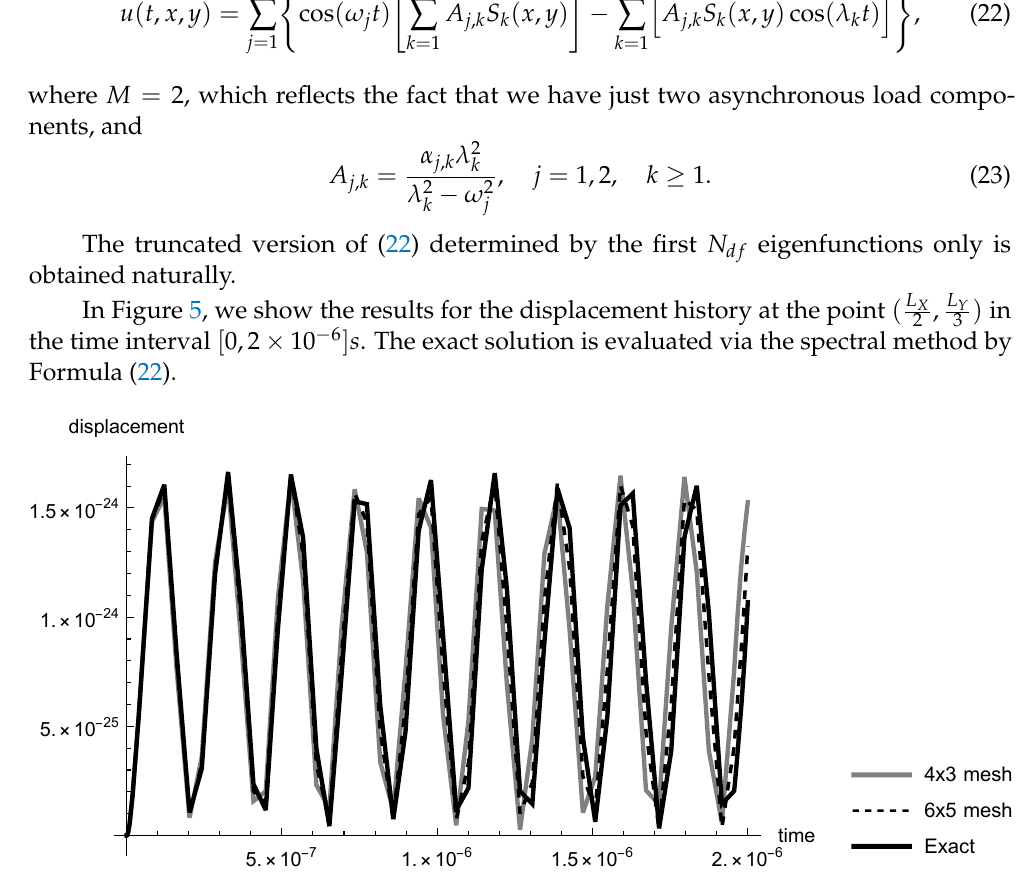
Figure 5. Comparison between the exact solution (solid line) and the approximate solution obtained by the FEM. Displacement history at the point ( L X